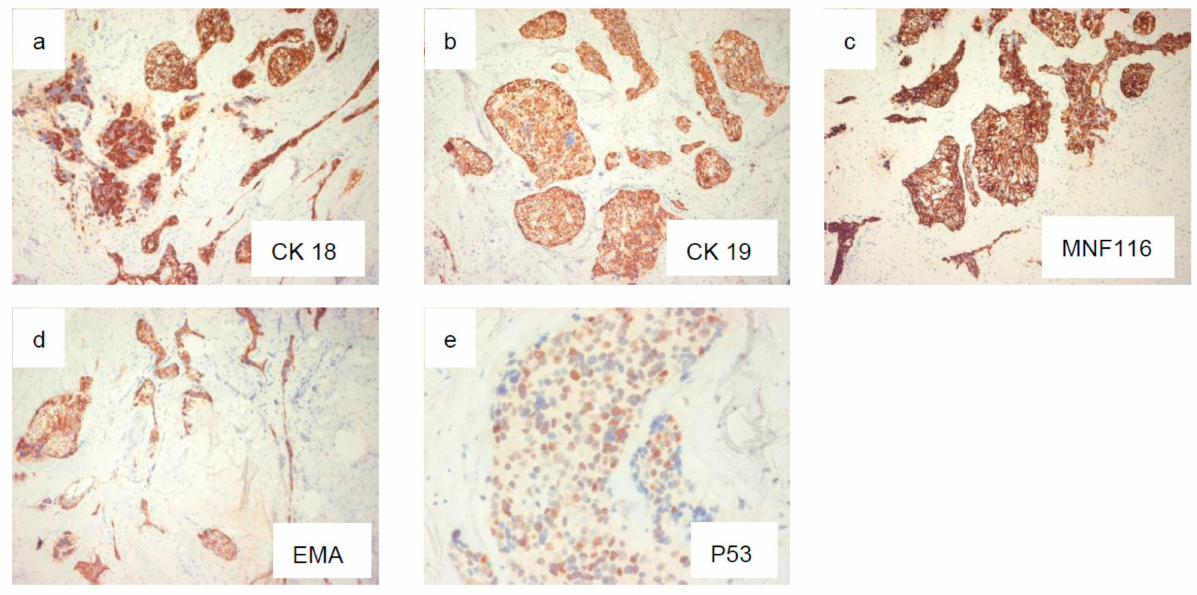
Figure 4. Positivity for AC anti-CK18 (( a ), × 4), CK19 (( b ), × 10), MNF116 (( c ), × 10), EMA (( d ), × 4), and P53 (( e ), ×